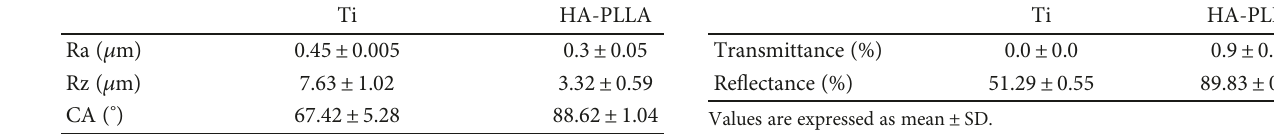
Values are expressed as mean ± SD . Ra: calculated average roughness; Rz: maximum height.